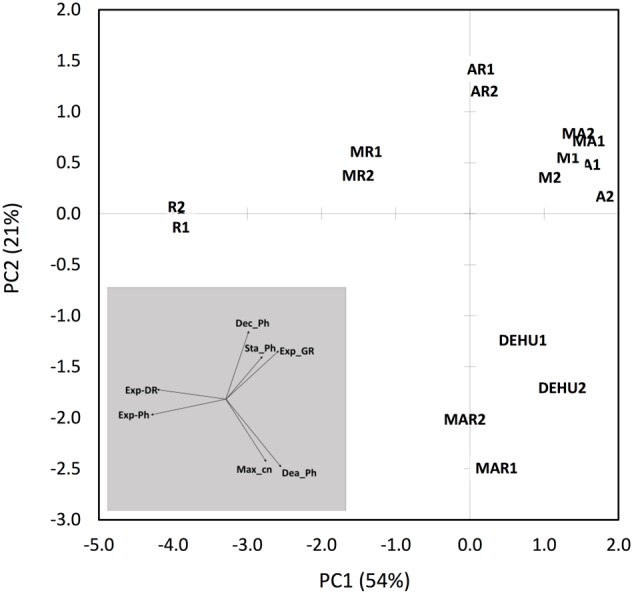
Two-dimensional principal component analysis (PCA) of dinoflagellate batch growth dynamics of G. catenatum cultures grown with different associate bacterial communities. Variables were normalized prior to analysis and included exponential growth and death rate, maximum cell concentration, and batch growth phase durations indicated by colored bars in Figures 2, 3. Replicate co-cultures are indicated by number suffix (1 or 2). See Table 1 for culture codes and additional detail (M, Marinobacter DG879; A, Alcanivorax DG881; R, Roseobacter DG874; MA, Marinobacter DG879 and Alcanivorax DG881; AR, Alcanivorax DG881 and Roseobacter DG874; MR, Marinobacter DG879 and Roseobacter DG874; MAR, Marinobacter DG879, Alcanivorax DG881 and Roseobacter DG874; DEHU, mixed bacterial community from non-axenic GCHU11 and GCDE08 parent cultures). Vectors of original batch curve variables used in the analysis are shown in the shaded plot. Variables: Dea_Ph, length of death phase in days; Dec_Ph, length of declining phase in days; Exp_DR, death rate (μ) during death phase; Exp_GR, growth rate (μ) during log-phase; Exp_Ph, length of dinoflagellate log-phase in days; Max_cn, maximum dinoflagellate cell concentration (cells ml-1); Sta_Ph, length of stationary phase in days.